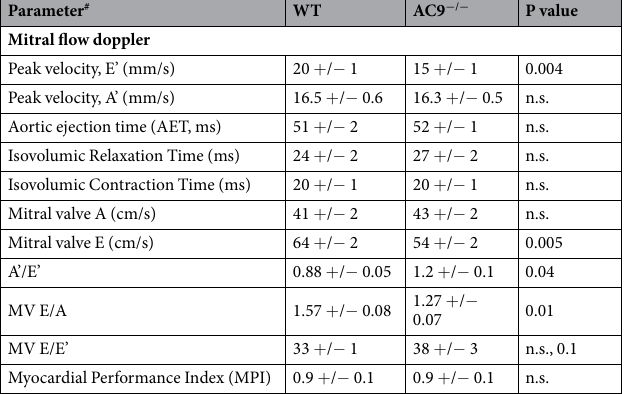
Table 2. Cardiac parameters for WT and AC9 − / − mice. # Mean + / − SE is given for male animals 3–7